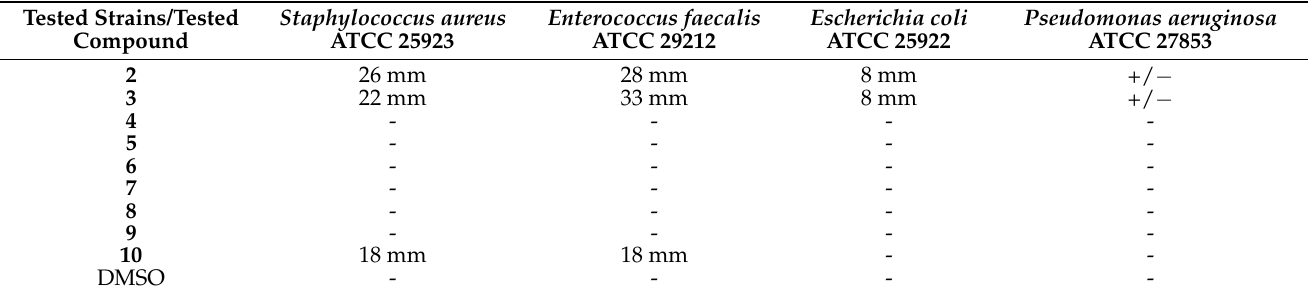
Table 1. Growth inhibition diameters obtained for the tested compounds against the tested strains.